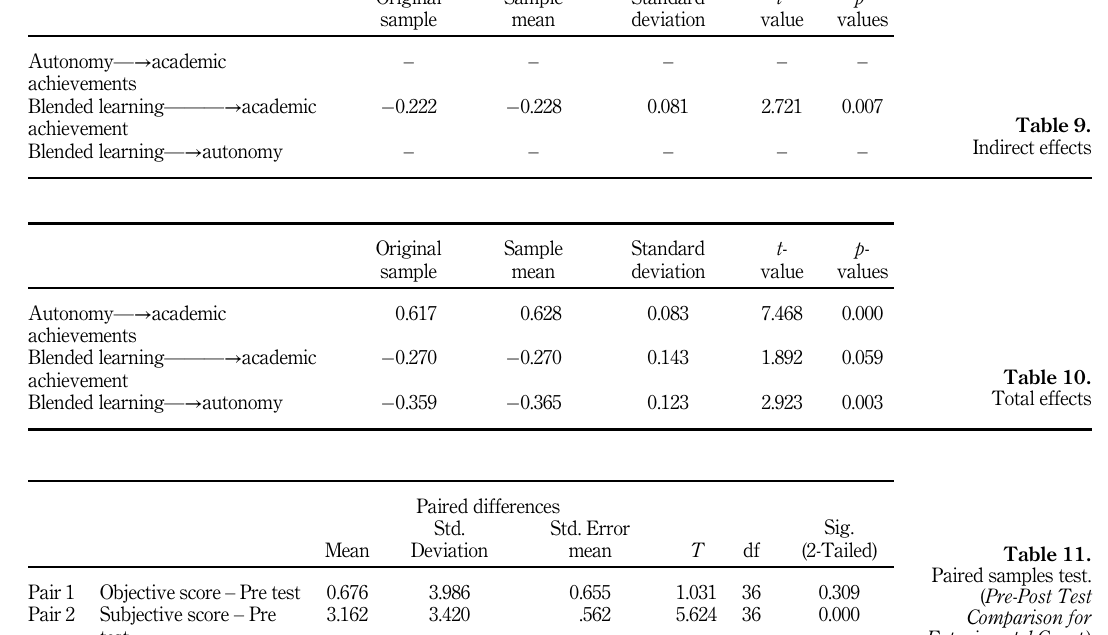
Table 11. Paired samples